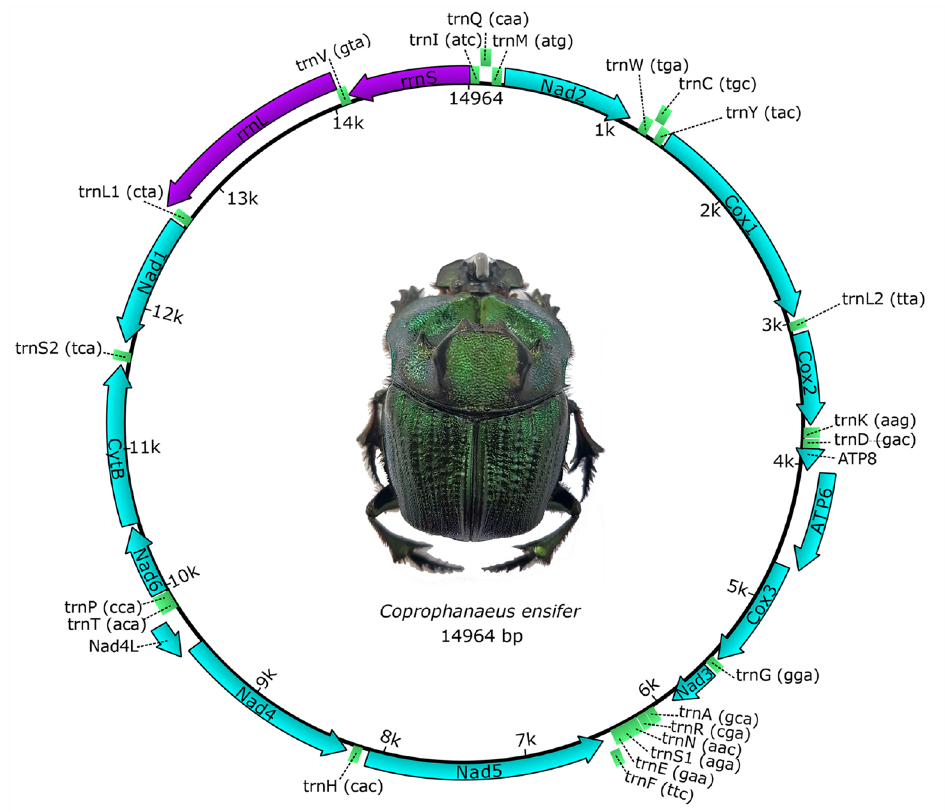
Figure 1. Organization genetic of Coprophanaeus ensifer mitogenome. Protein-coding genes, tRNA genes and rRNA genes are shown in blue, green and purple, respectively. The arrows indicate the direction of the